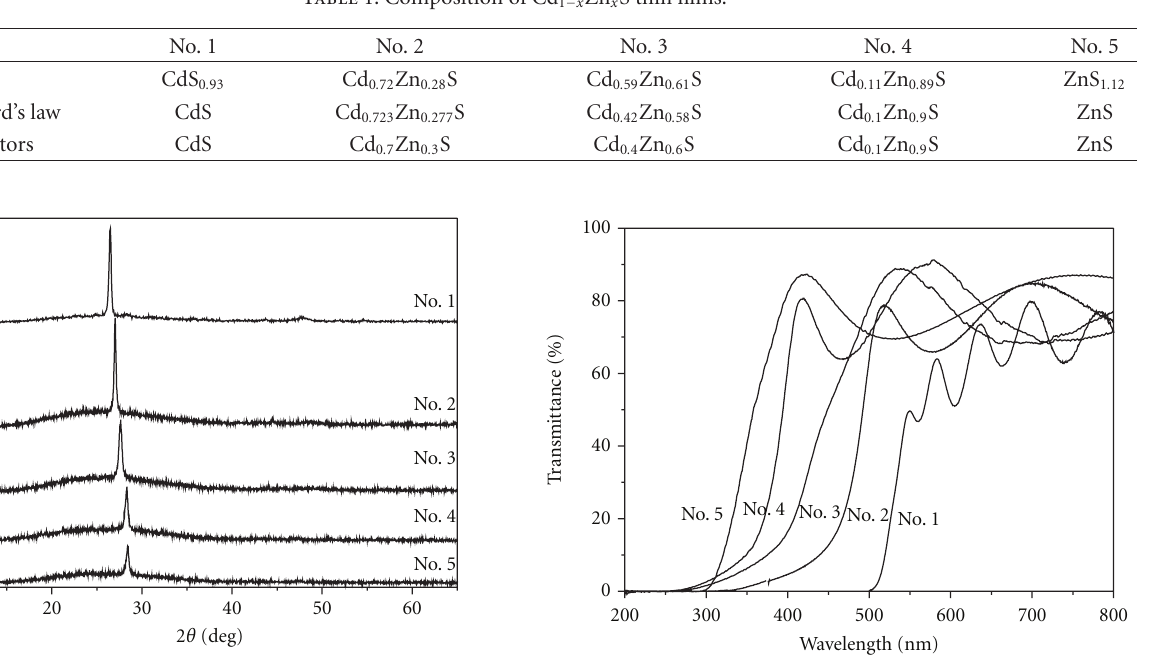
orientation of (111) plane at the ZnS end to being hexagonal wurtzite with a preferential orientation of (002) plane when zinc content decreased.